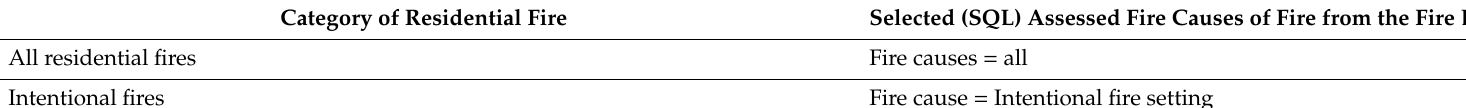
Table 1. Categorization of residential fires and their related causes (Data source: Emergency Services